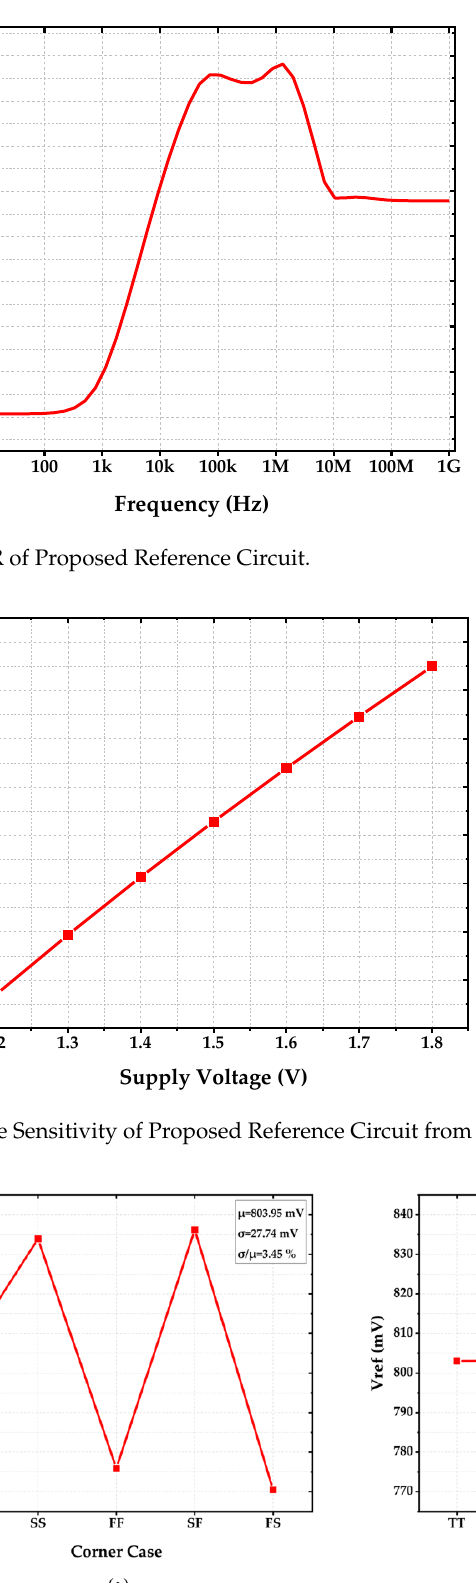
Figure 12. Monte-Carlo Simulation of Process Sensitivity ( a ) at −4 0 ℃ ( b ) at 27 ℃ ( c ) at 90 ℃.